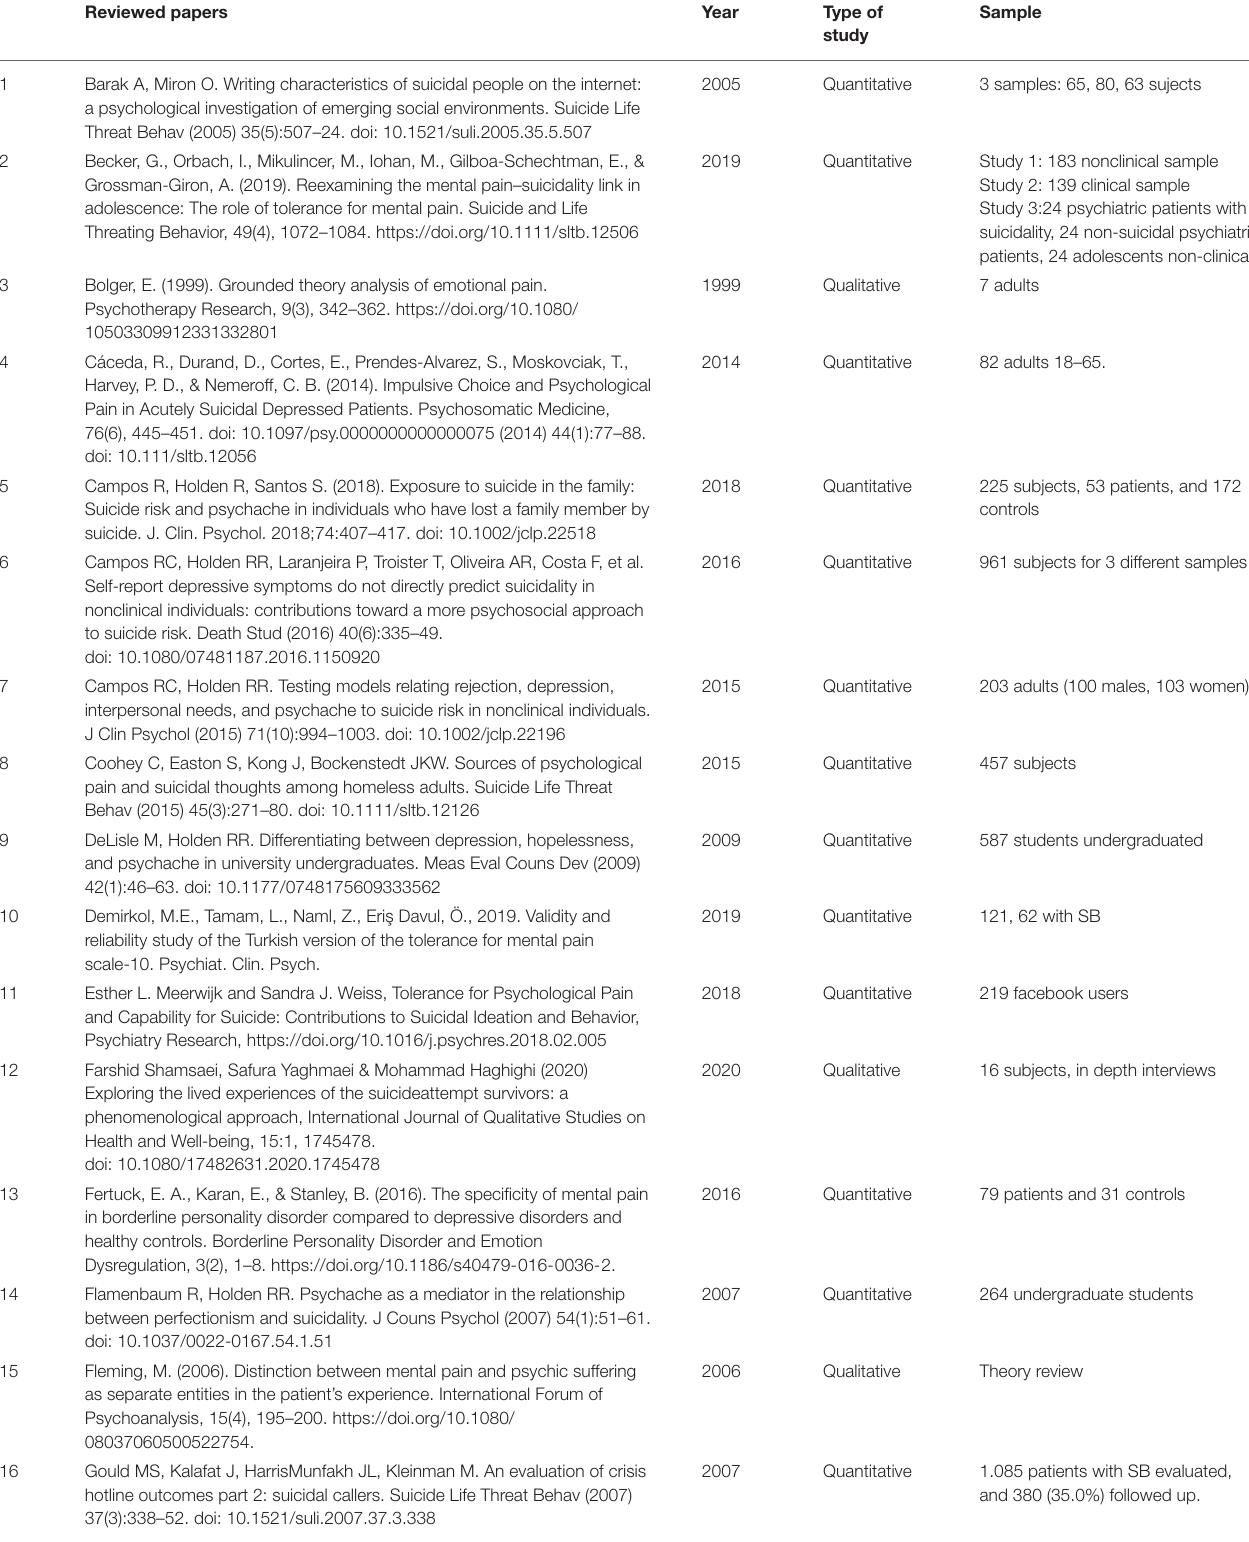
TABLE 1 | Detail of papers in comprehensive review of scientific publications that studied the concept of mental pain. Reviewed papers